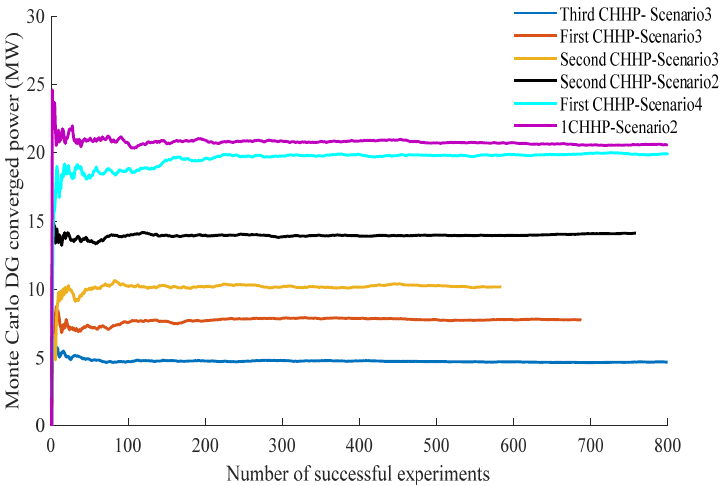
Figure 14. Converged power of CHHP.